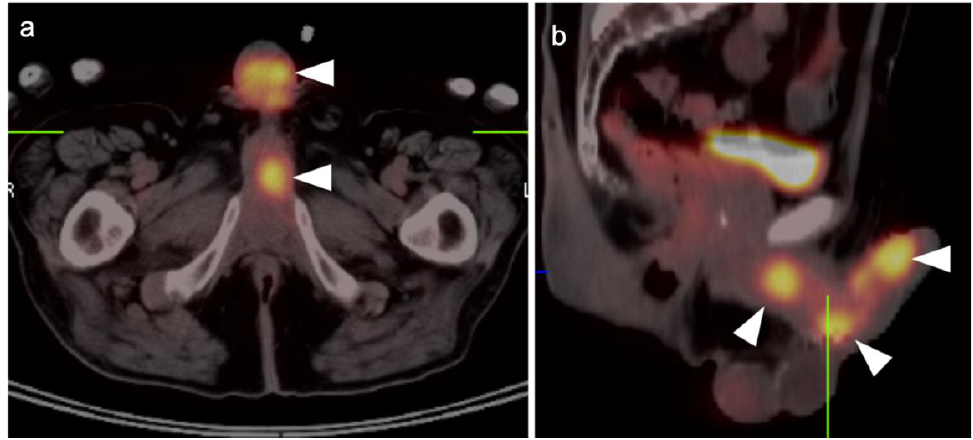
Figure 55. Metastases to the penis. Axial ( a ) and sagittal ( b ) FDG PET-CT images demonstrate mul- tiple hypermetabolic masses involving the penis (white arrowheads). The primary tumor was a si- nonasal undifferentiated carcinoma (SNUC).